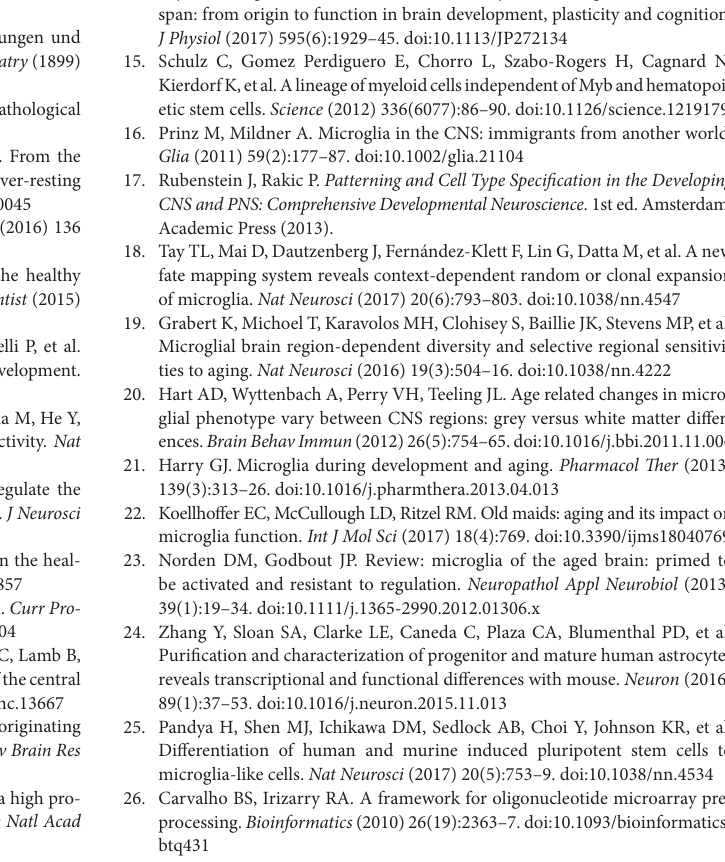
FigUre s1 | Donut plot showing various protein classes associated with the differentially expressed gene set or 3,290 genes. FigUre s2 | Correlation matrix/correlogram showing varying correlation ranging from very weak to very strong (0.0–0.99) among significant brain ages within three microglia-enriched regions, namely AMY, HIP, and STR. The color bar depicts the range of correlation coefficient ( − 1, 1) and in each correlogram, the colored slice in the pie increases in size and intensity in accordance with the correlation coefficient